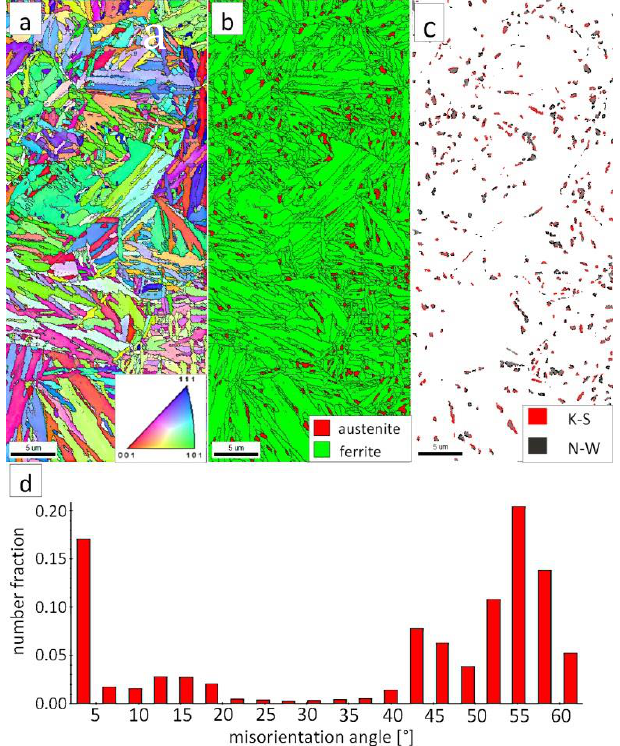
Figure 19. ( a ) IPF Map of the FZ. ( b ) Phase distribution map of the FZ. ( c ) Phase distribution map with indicated boundaries of N-W (marked in black) and K-S (marked in red) orientations. Ferrite-white, austenite-gray. ( d ) Misorientation angles distribution of the FZ.